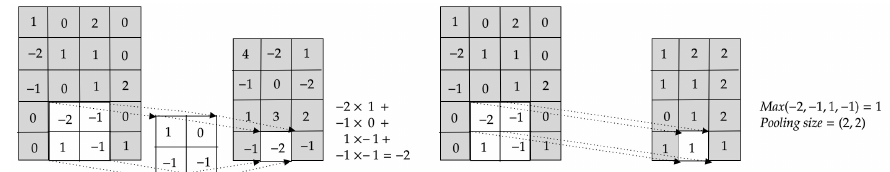
Figure 1. The left side image is the example of the convolutional operation, and the right side is the example of a max-pooling operation with pooling size (2,2).